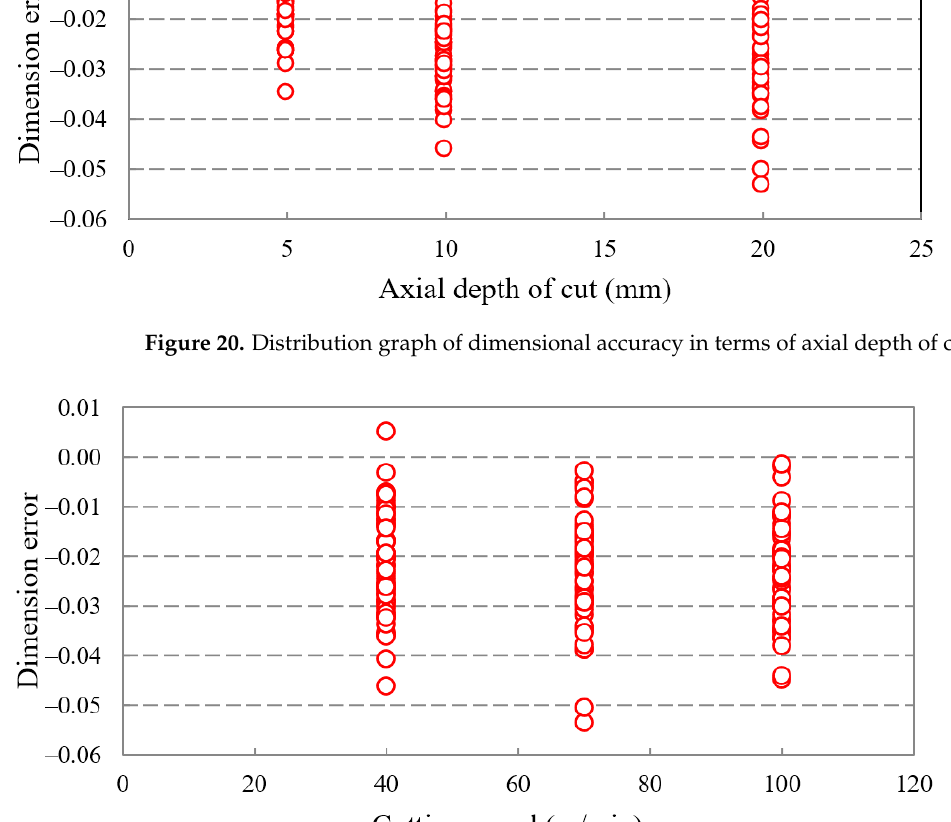
Figure 21. Distribution graph of dimensional accuracy in terms of cutting speed.